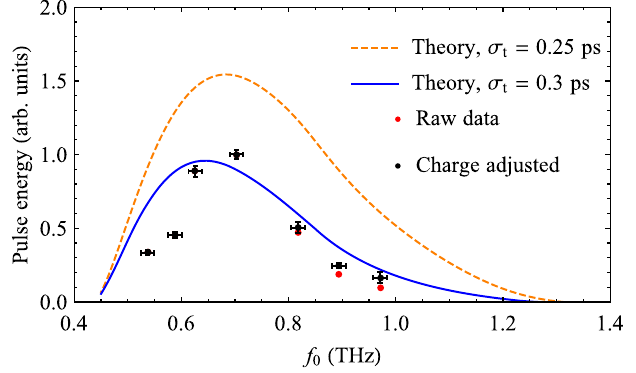
FIG. 5. Variation of CCR pulse energy as a function of fundamental frequency. The data (red dots) is also adjusted for loss of charge due to finite transverse electron beam size (black dots). Solid and dotted lines are theoretical dependencies for two bunch lengths of 0.30 ps and 0.25